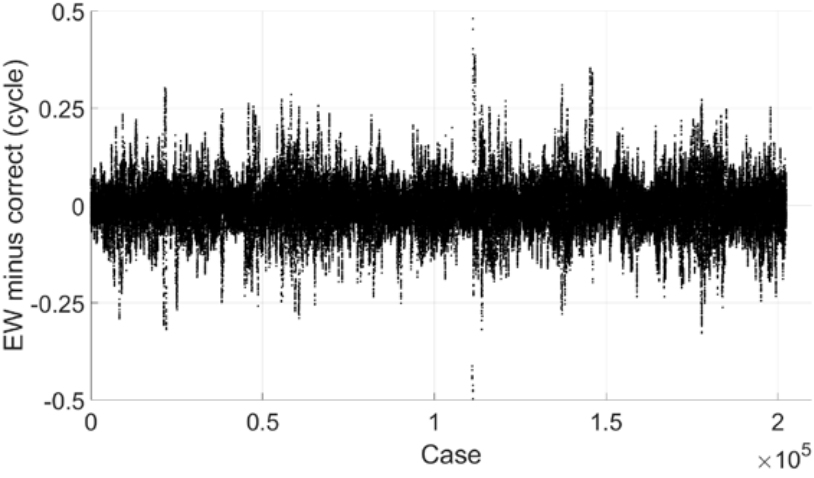
Table 4. Wide-lane combination of GPS.